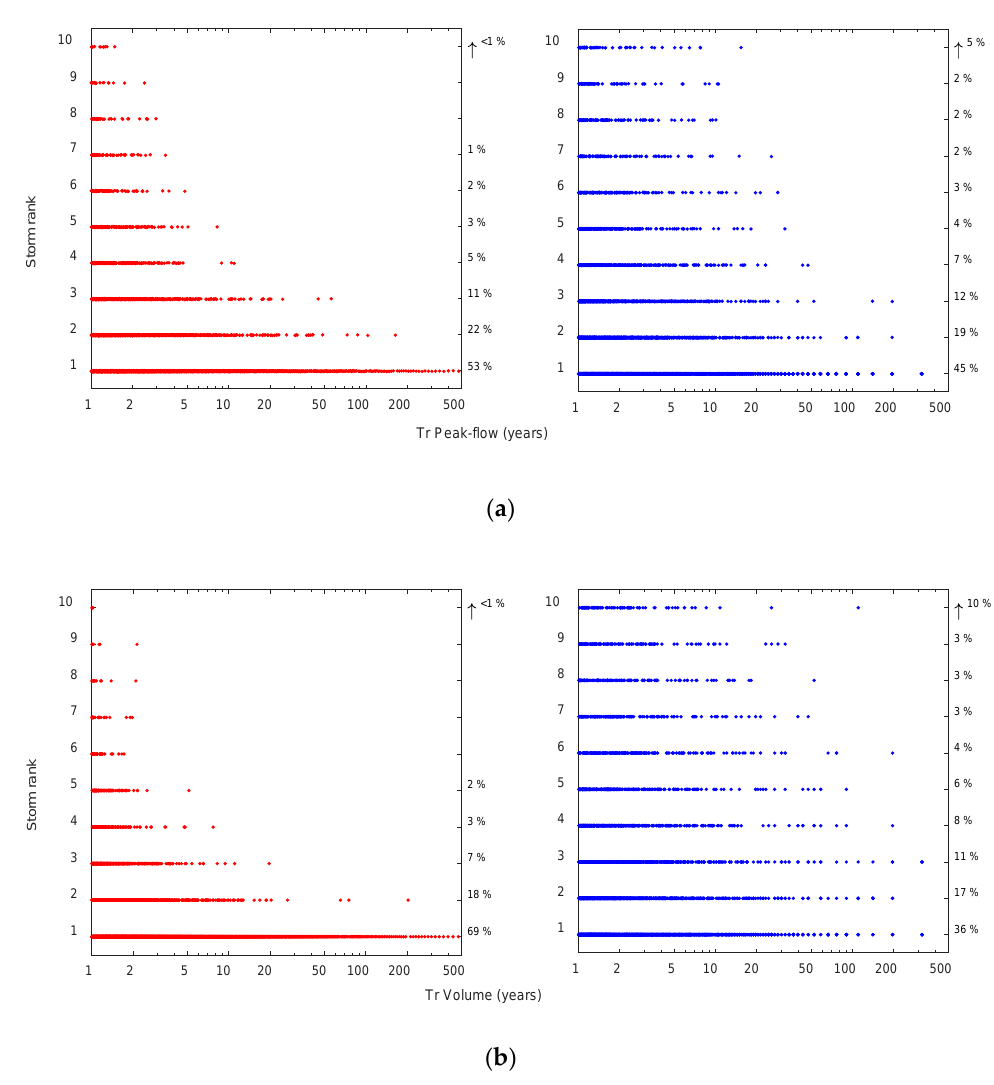
Figure 5. Storm order that corresponds to every return period (Tr) of maximum annual peak-flow ( a ) and maximum annual volume ( b ) represented as red dots for the total depth criteria and as blue dots for the maximum intensity rank criteria. The numbers on the right represent the probability that a storm of a specific rank generates the maximum peak-flow ( a ) or volume ( b ) of given a year.